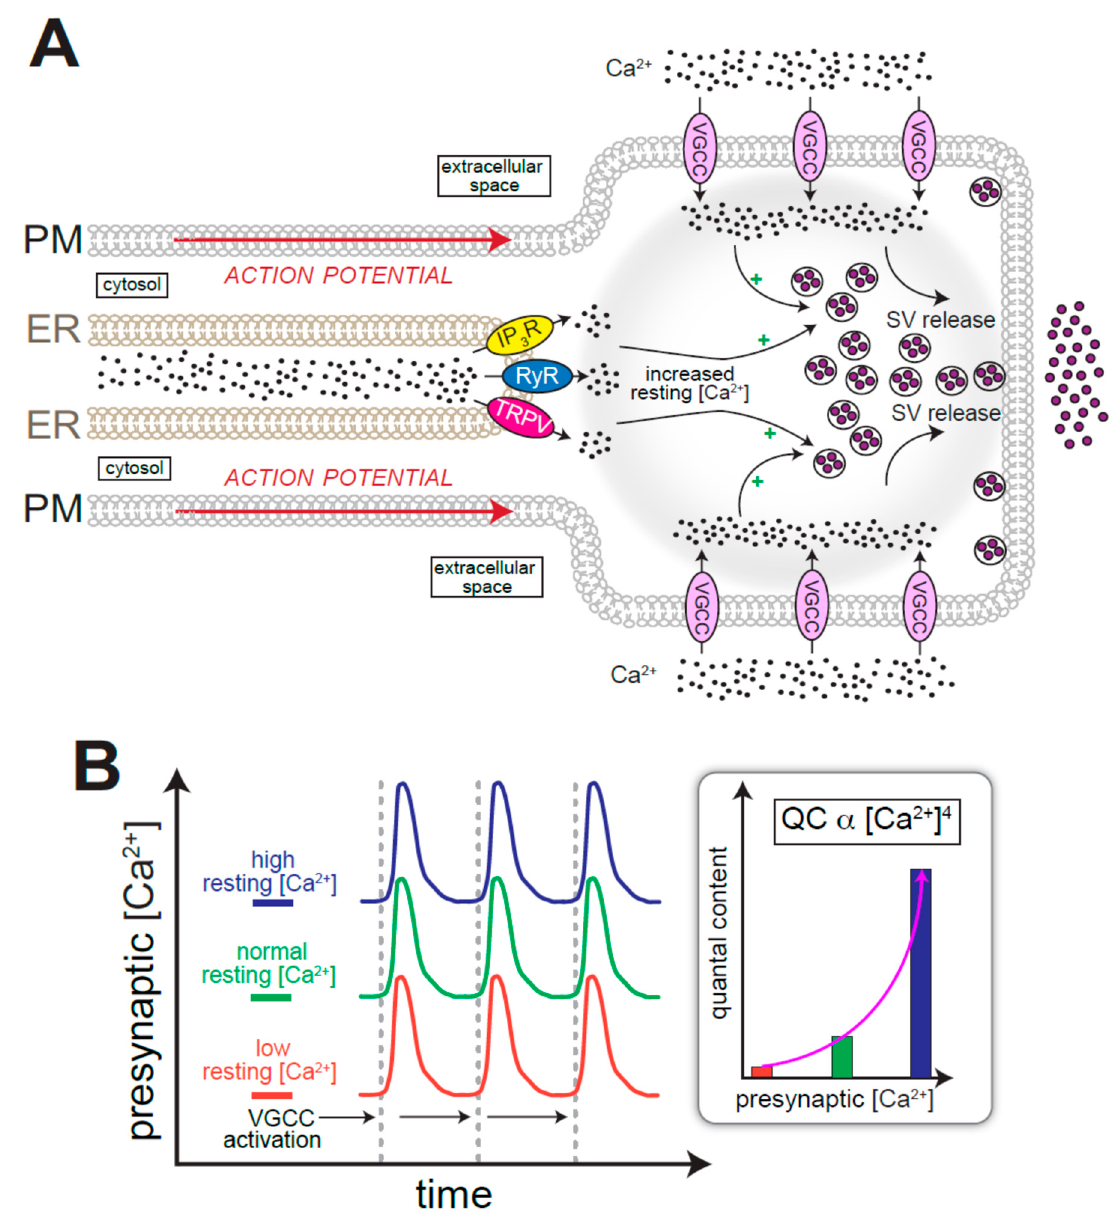
Figure 2. Influence of ER Ca 2+ release on synaptic vesicle (SV) release and neurotransmission. ( A ) Action potentials are propagated through axons. Depolarization of presynaptic membrane activates voltage-gated Ca 2+ channels (VGCCs), which causes Ca 2+ to enter the synapse. ER Ca 2+ release contributes to cytosolic [Ca 2+ ], which influences release of neurotransmitter-laden SVs. ( B ) ER Ca 2+ release, whether increased or decreased, affects the presynaptic cytosolic [Ca 2+ ]. The presynaptic cytosolic [Ca 2+ ] scales linearly upon activation of VGCCs. The magnitude of SV release obeys a 4th power relationship with presynaptic cytosolic [Ca 2+ ], allowing small elevations in [Ca 2+ ] to cause large increases in neurotransmitter release (inset).